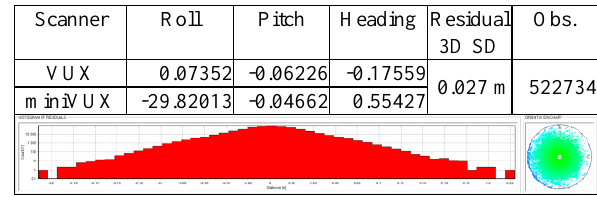
Table 3. Boresight calibration result for the six (3+3) angular orientation